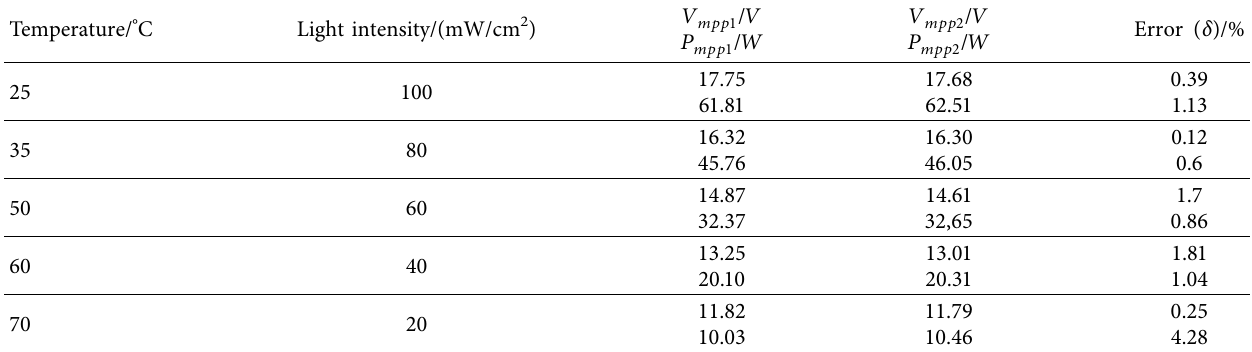
Figure 5: The relations between V Table 1: Comparison between Newton-Raphson and proposed methods.